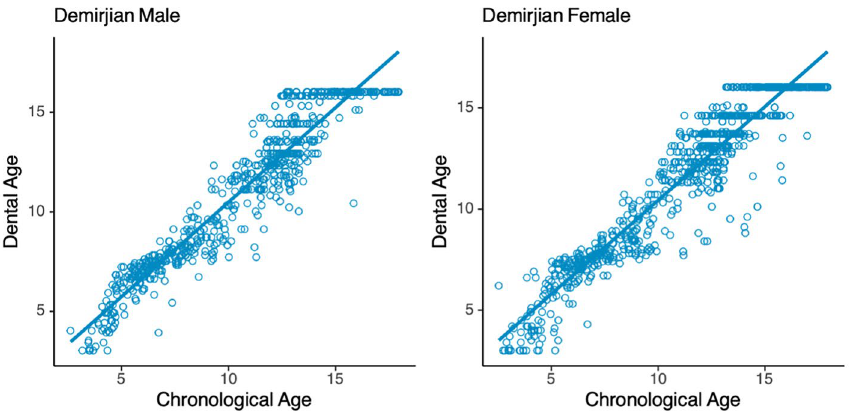
Figure 1. Distribution of chronological age and dental age ( Demirjian ).